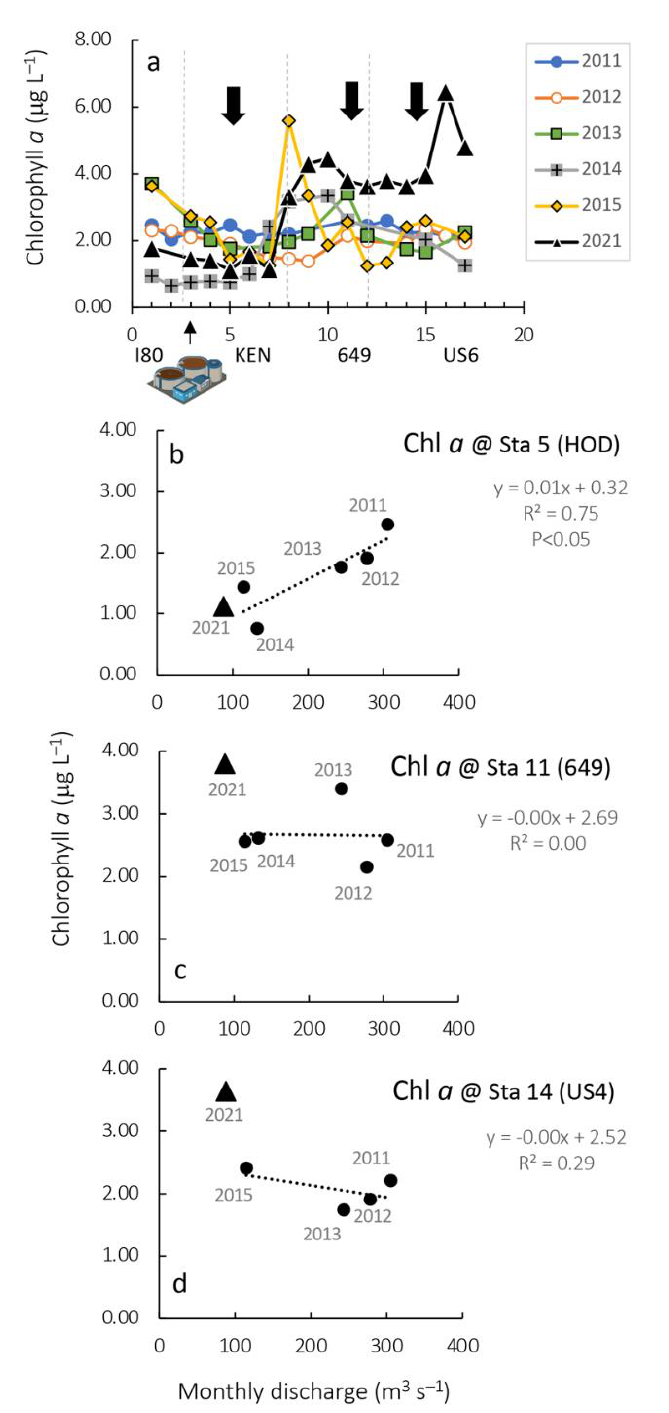
Figure 6. Transects of chlorophyll a (panel a ) for the six years of sampling undertaken in the Bay Delta during September/October. Sampling in 2021 was 5 months after full implementation of the upgraded WWTP. Vertical dashed lines separate the major segments of the river/estuary. The WWTP icon shows location of discharge. Note the sustained increase in chl a after station 7 in 2021, a trend not seen in the other years. The correlations of average monthly discharge and chlorophyll a concentrations at station 5 (HOD), at station 11 (649), and at Station 14 (US4) are shown in (panels b – d ), respectively. Note the stations for which relationships with discharge are shown are highlighted by black arrows in (panel a